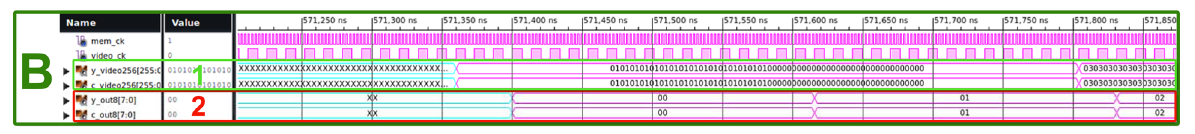
Fig. 9 The simulation screenshot corresponds to line reconstruction